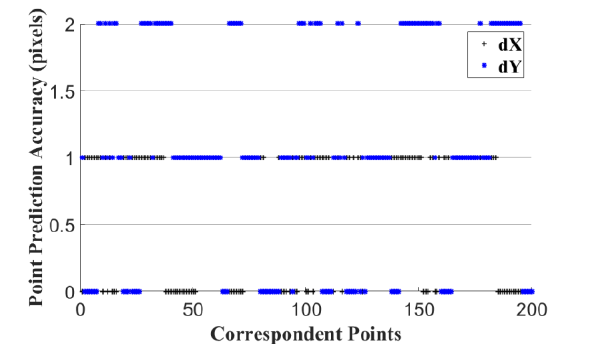
Figure 9. Point prediction accuracy Image Matching Results: The top plot of Figure 10 shows the image matching results on approximate orthophotos.